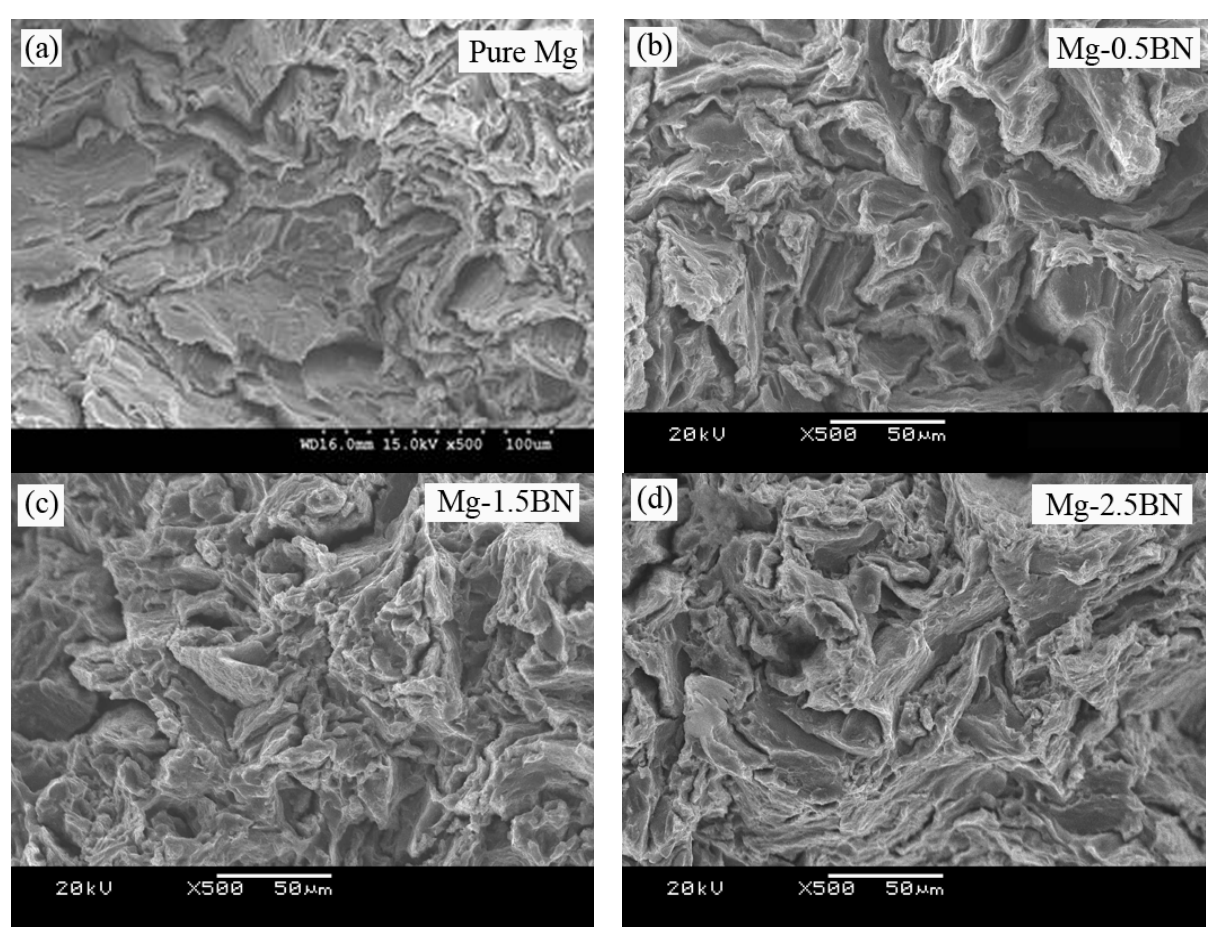
Figure 4. Tensile fracture surfaces of ( a ) pure Mg; ( b ) Mg-0.5BN; ( c ) Mg-1.5BN; and ( d ) Mg-2.5BN composites; ( e ) a high magnification image showing increased slip activity in